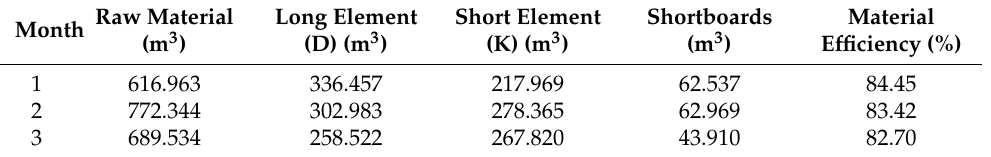
Table 7. The results of sawn timber prefabrication for furniture elements according to the variant “Bp”. Raw Material Month (m 3 )